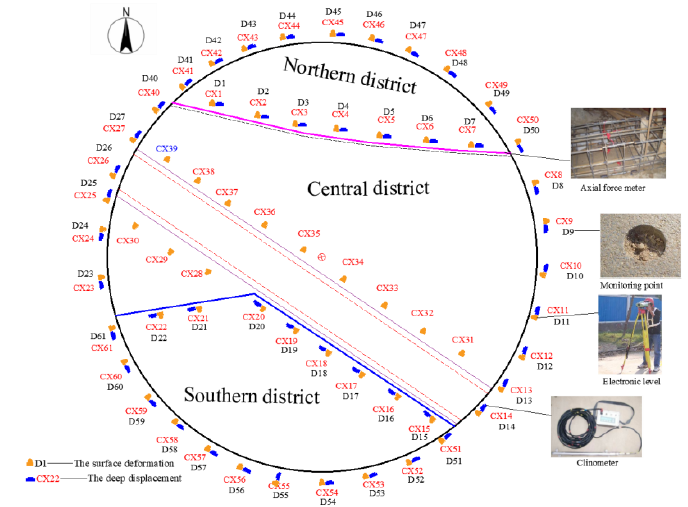
Figure 21. The location of measuring points.